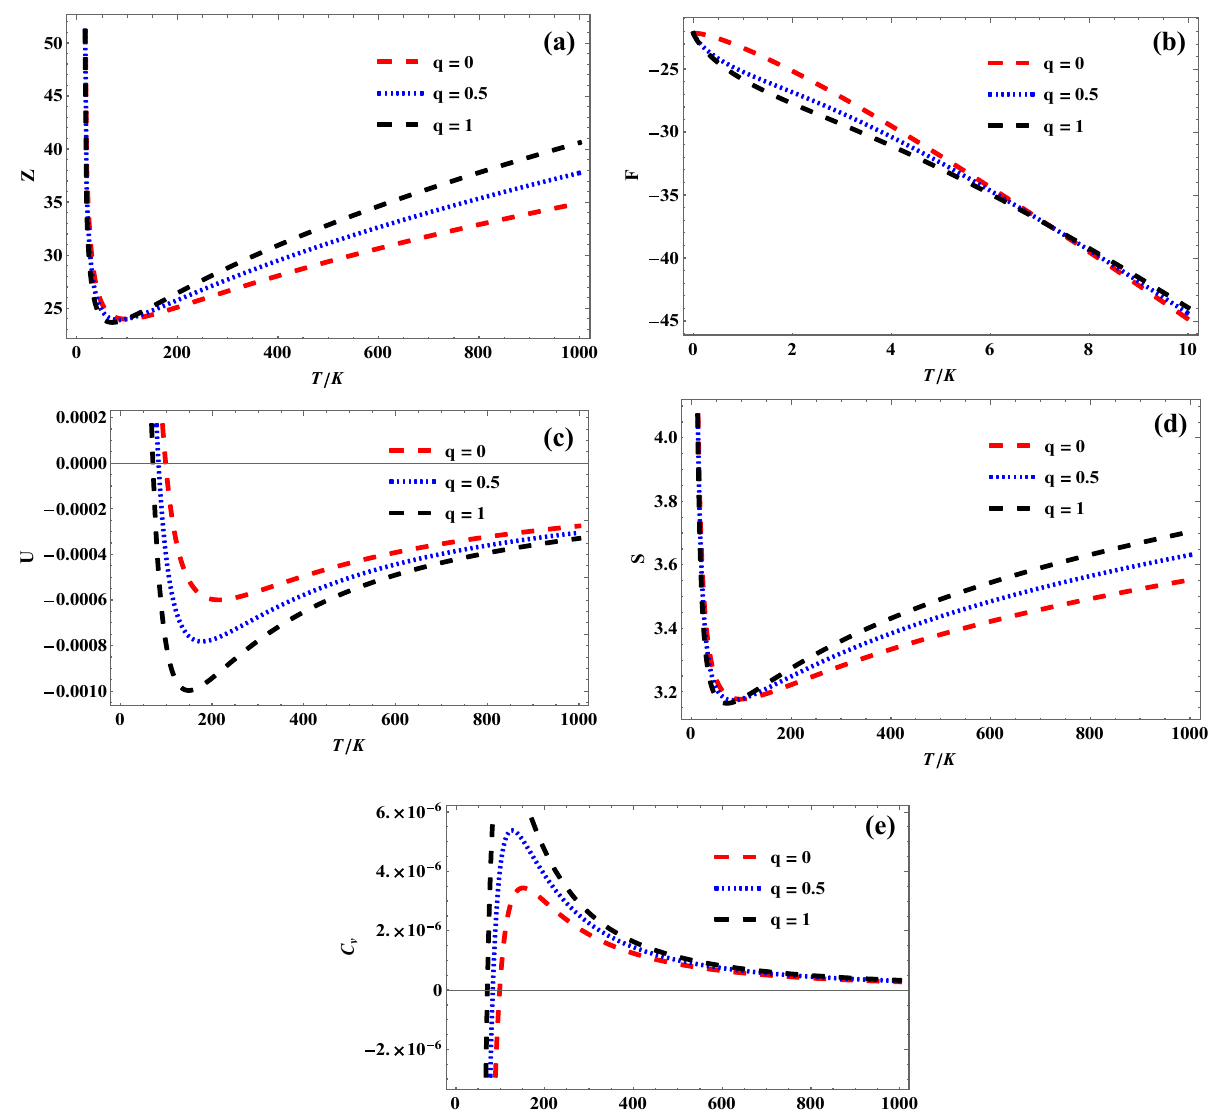
Figure 4. ( a ) Variation of partition function of quantum pseudoharmonic oscillator with temperature for selected q -values with κ = 1. ( b ) Variation of free energy of quantum pseudoharmonic oscillator with temperature for selected q -values with κ = 1. ( c ) Variation of internal energy of quantum pseudoharmonic oscillator with temperature for selected q -values with κ = 1. ( d ) Variation of entropy of quantum pseudoharmonic oscillator with temperature for selected q -values with κ = 1. ( e ) Variation of specific heat capacity of quantum pseudoharmonic oscillator with temperature for selected q -values with κ =